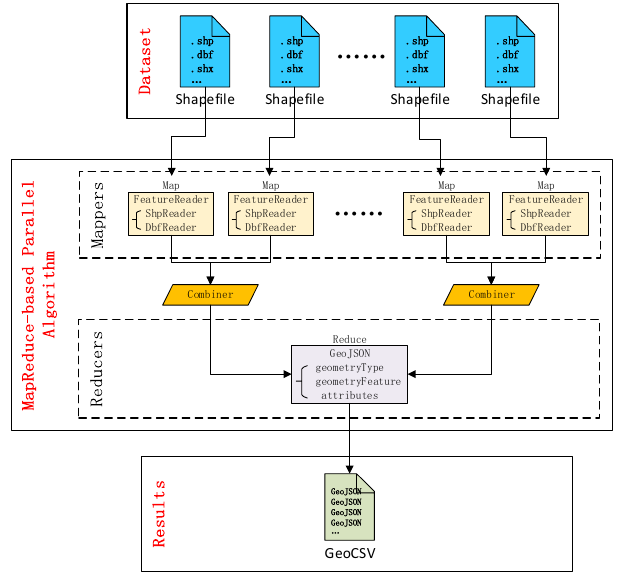
Figure 3. The MapReduce-based parallel data conversion algorithm.